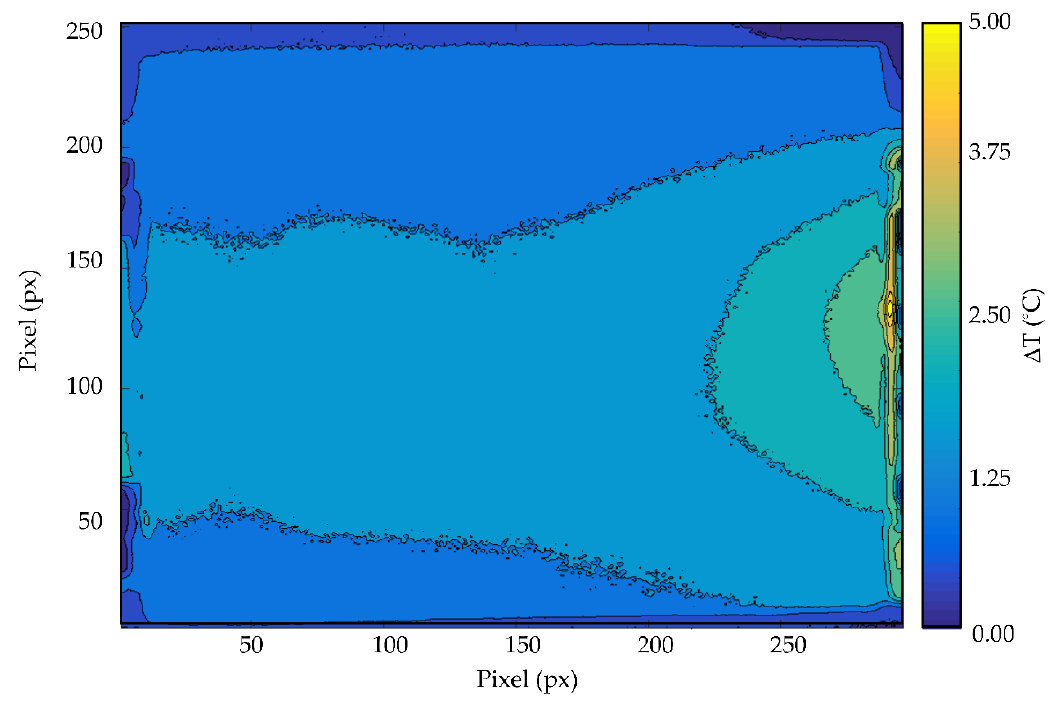
Figure 7. Illustration of distribution of temperature increases observed in the investigated prototype sample after 60,000 cycles of charging/discharging at a current density of 5 A/g and polarizing voltage 1.5 V; no serious changes of C and R ESR were recorded.